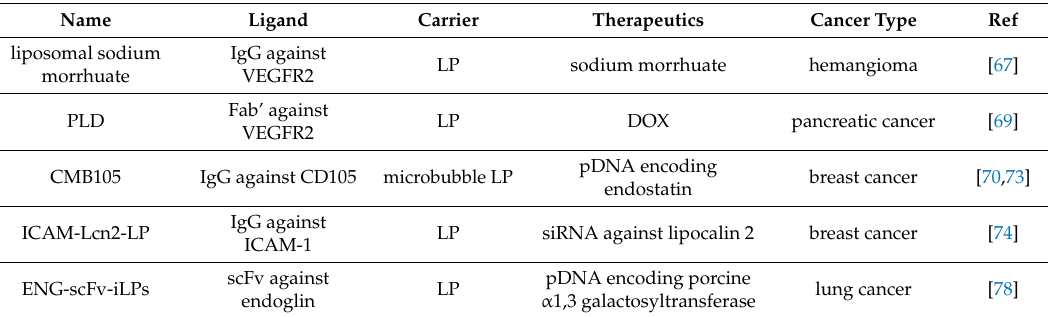
Table 4. Antibody-modified nanoparticles.